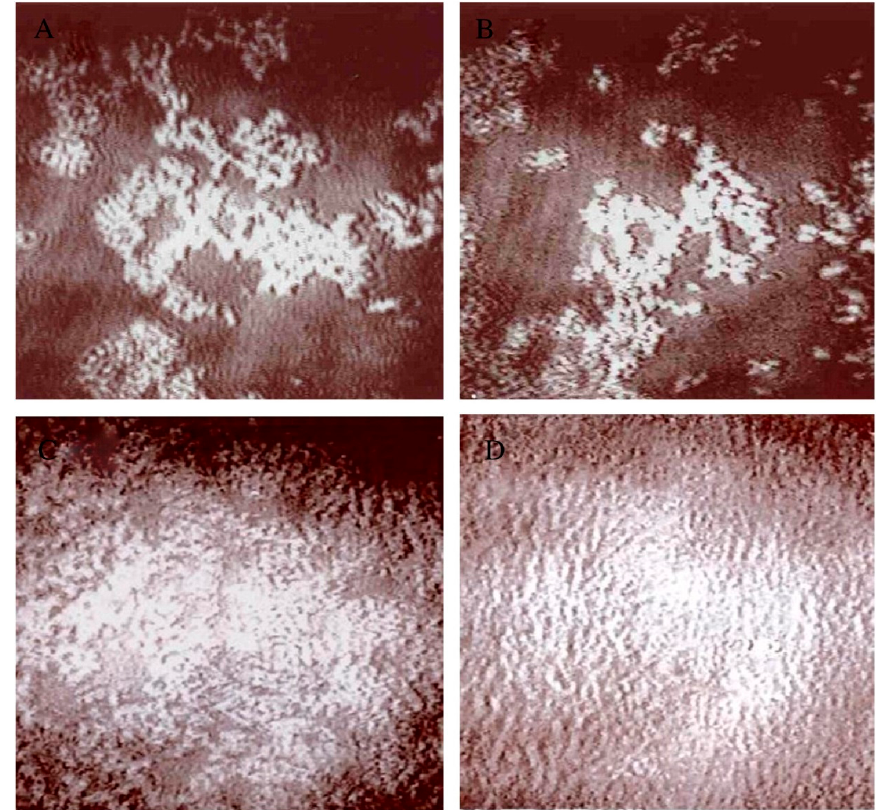
Figure 6. BAM images of DMPC and cholesterol mixed monolayers interacting with 1.0 μ M tomatine. ( A ) 9:1 mole ratio at 15 min after injection, ( B ) 9:1 mole ratio at 50 min after injection, ( C ) 8:2 mole ratio at 120 min after injection, ( D ) 5:5 mole ratio at 120 min after injection. The monolayers were compressed to 10 mN m − 1 prior to injection. The images are 700 μ m × 700 μ m. Reproduced with permission from reference [82].